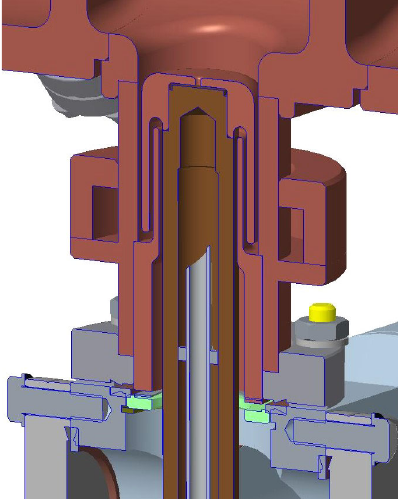
FIG. 6. Cross section of the folded coaxial